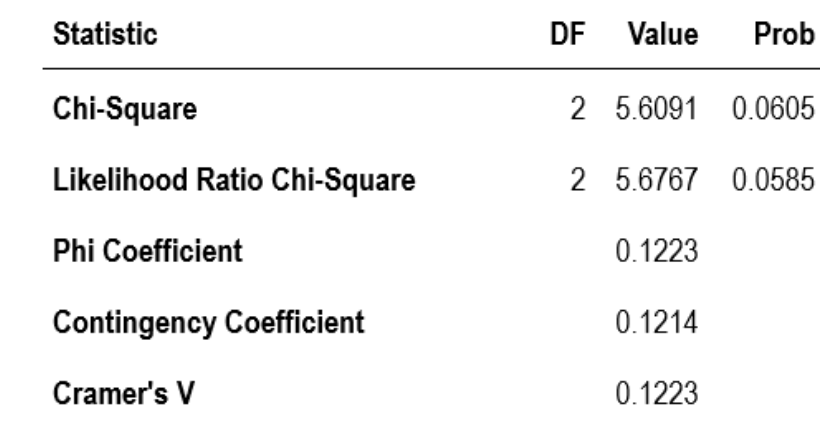
Assessment of the association between preferred form of education and level of